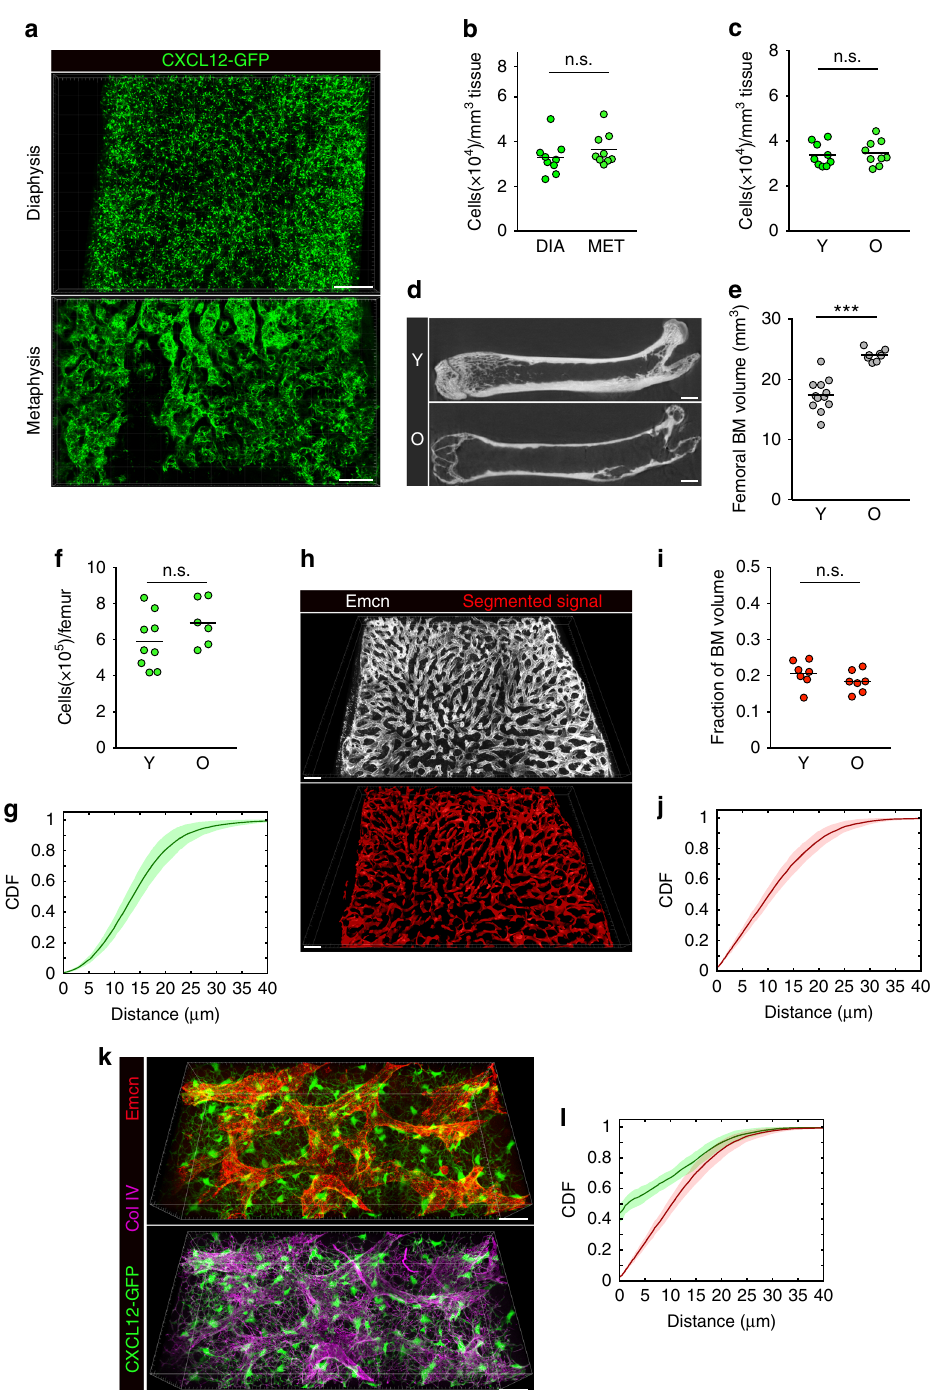
Fig. 7 Analysis of CARc and sinusoidal vessel networks in ageing. a , b Representative 3D images and quanti fi cation of CARc densities in the femoral metaphysis and diaphysis of old (O) mice. Scale bars, 200 µ m. c Mean CARc densities in femoral BM of young (Y, 2 – 3 m/o) and old (O, 20 – 24m/o) mice. b , c Bars show the mean and dots represent individual values for single femurs from different mice ( n = 9 per group). d , e Representative µ -CT images (orthogonal projection corresponding to a 200 µ m thickness; scale bar, 1 mm) and quanti fi cation of total BM volume of Y and O mice (*** P < 0.0001). Bars show the mean and dots represent individual values for single femurs from different mice ( n = 12 per group). f Absolute numbers of CARcs in single femurs of Y and O mice. h Confocal image and segmented reconstruction of the Emcn signal in BM of aged mice. Scale bars, 100 µ m. i Fraction of BM volume occupied by sinusoids in femurs from Y and O mice. Bars show the mean and dots represent individual values for different femurs ( n = 7 per group) (n.s. not signi fi cant with P < 0.01). g – j CDF of the ESD to CARcs ( g ) and sinusoidal vessels ( j ) in aged BM. k High-resolution image of CARc networks, ECM and sinusoidal vessels in femoral BM from one aged mouse. Scale bar, 20 µ m. l CDF of the distance to nearest sinusoid evaluated at all positions (red), as well as evaluated at CARc centroids (green) in BM from old mice. Solid lines represent mean distance and envelopes indicate standard deviations. Statistical signi fi cance was analysed using two-sample Kolmogorov – Smirnov and P < 10 − 21 for all samples. Data in g , j , l correspond to images of large BM regions of metaphysis and diaphysis of femoral bones from seven different